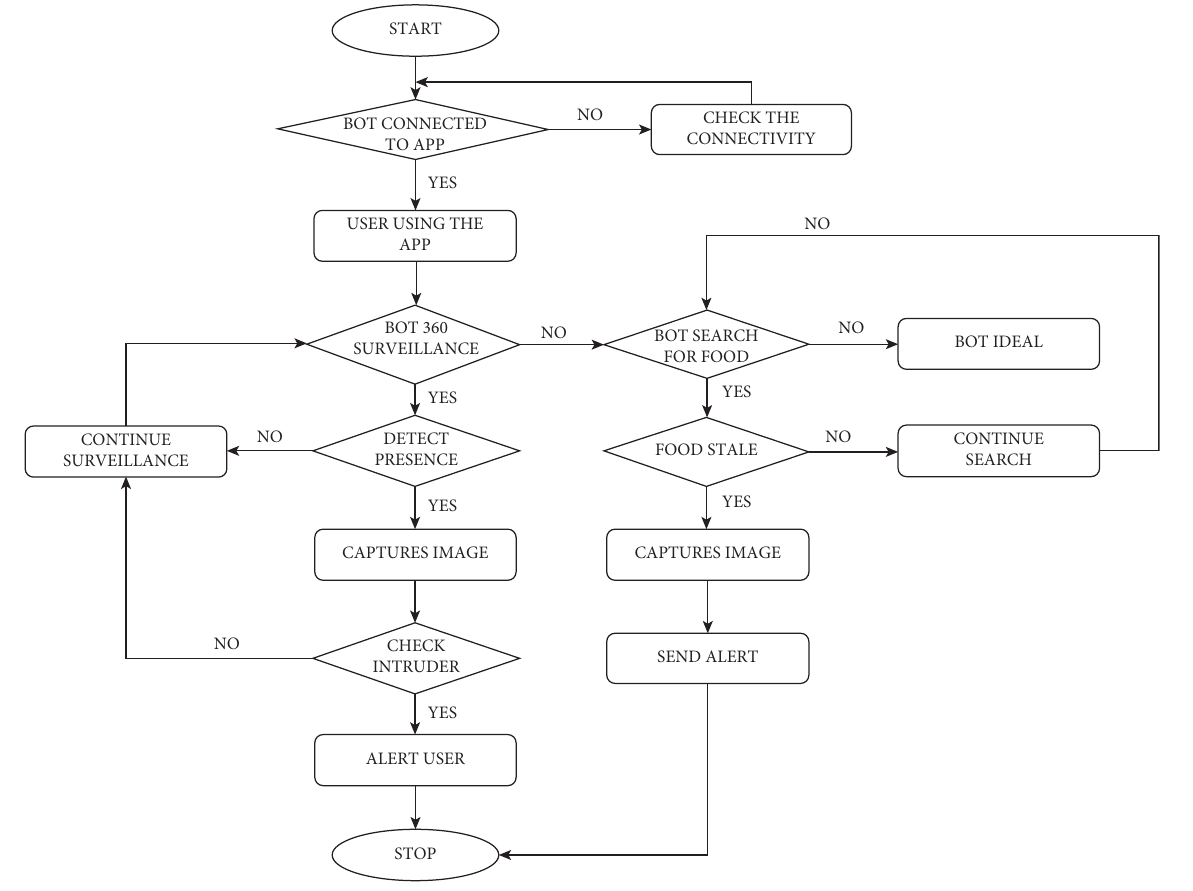
Figure 15: Flowchart of image processing.